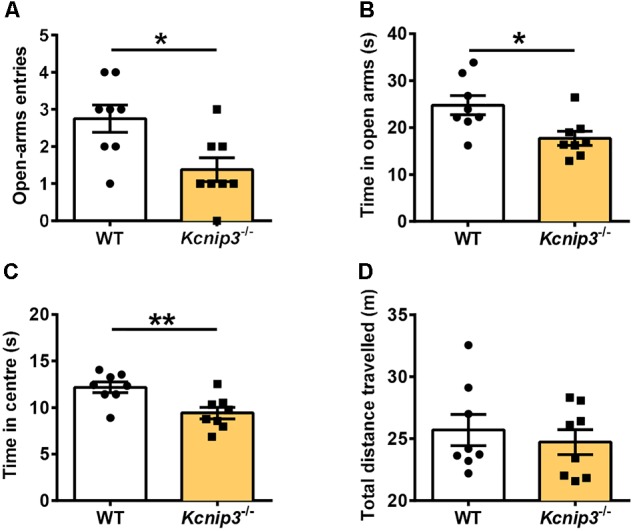
Enhanced anxiety-like behavior in Kcnip3-/- rats during inflammatory pain. (A,B) The elevated plus-maze test. Kcnip3-/- rats made fewer visits to the open arms (A) and spent less time in the open arms (B) in a 5-min test 1 day after CFA injection compared to the wild-type rats. n = 8 for both groups. ∗p < 0.05, unpaired t-test. (C,D) The open field test. (C)
Kcnip3-/- rats displayed less time spent in the center of the open field in a 5-min test 1 day after CFA injection compared to the wild-type rats. n = 8 for both groups. ∗∗p < 0.01, unpaired t-test. (D) Wild-type and Kcnip3-/- rats exhibit similar locomotor activity in the open field test 1 day after CFA injection. n = 8 for both groups, unpaired t-test.